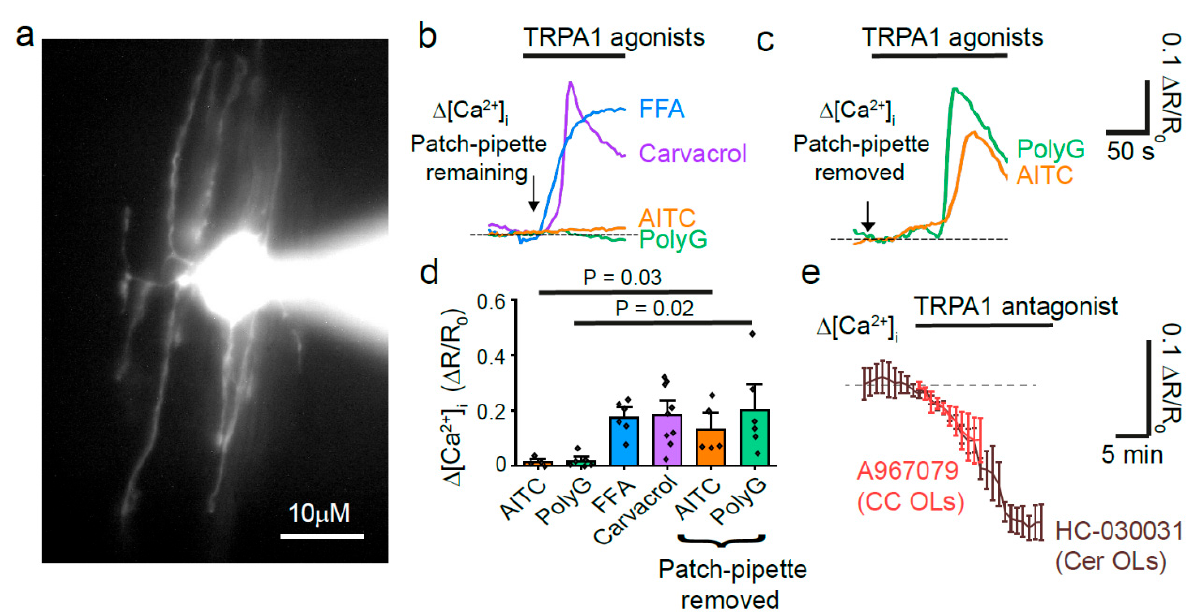
Figure 1. Corpus callosum oligodendrocytes express TRPA1. ( a ) High magnification of a whole-cell patch clamped OL in corpus callosum (CC) with Alexa dye in the soma and processes. ( b ) Representative Δ [Ca 2+ ] i trace responses to TRPA1 agonists with the patch-pipette remaining: FFA 100 µ M ( n = 6); carvacrol 2mM ( n = 8); 500 µ M AITC ( n = 4); polygodial 100 µ M ( n = 6). ( c ) ∆ [Ca 2+ ] i to TRPA1 agonists with the patch-pipette removed: AITC 500 µ M ( n = 5); polygodial 100 µ M ( n = 6). ( d ) Mean ± SEM maximum ∆ [Ca 2+ ] i in response to TRPA1 agonists ( p -values compared with and without patch pipette, one-way ANOVA test with Holm-Bonferroni correction for multiple comparisons). ( e ) The graph shows a decrease in resting [Ca 2+ ] i that occurs in the presence of TRPA1 antagonists: A-967079 20 µ M in CC Ols and HC-030031 100 µ M in cerebellar (Cer) OLs.